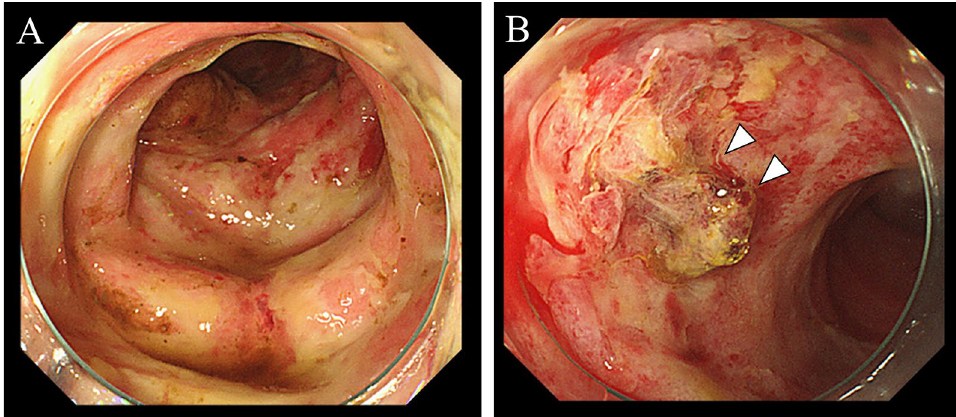
Fig. 3 A Emergency colonoscopy revealed extensive mucosal erosions in the ascending colon to cecum. B Deep ulcer with a exposed blood vessel were observed in the terminal ileum